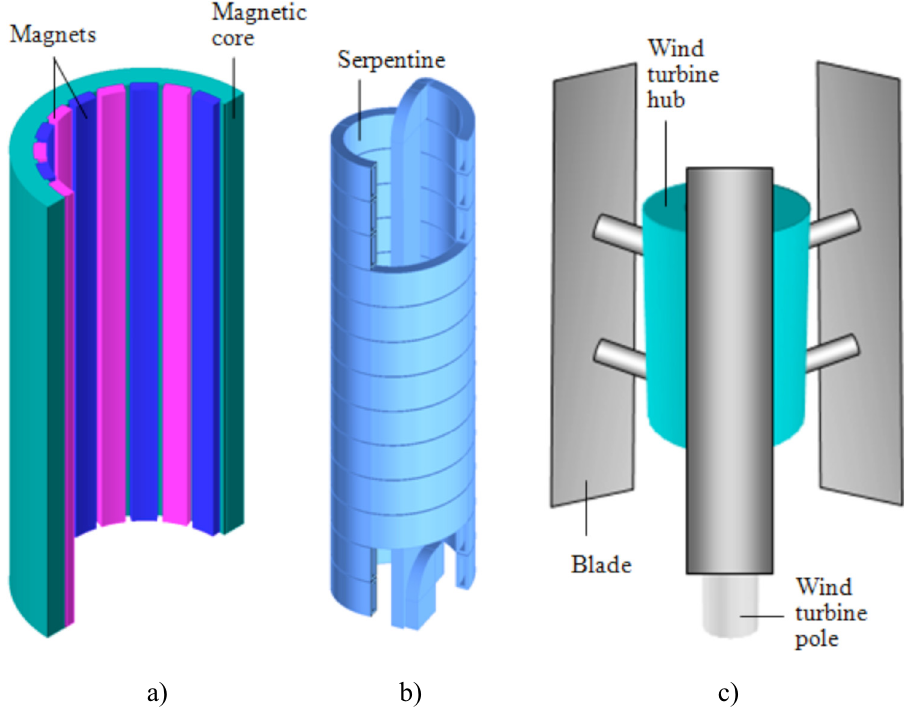
Fig. 1. ORPMECH for wind turbines; (a) outer rotor of the device equipped with PMs; (b) inner stator of the device (steel tube serpentine); (c) vertical axis wind turbine with its hub mounted directly on the outer rotor of the device.